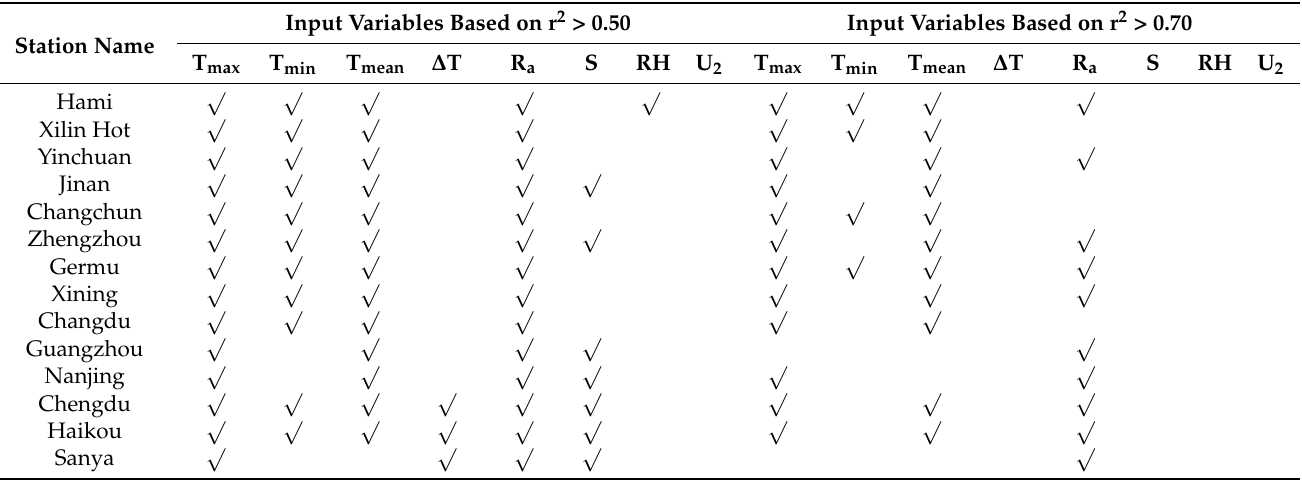
Table 2. The selection of input variables for BP and GABP models at the 14 national meteorological stations based on r 2 > 0.50 and r 2 >